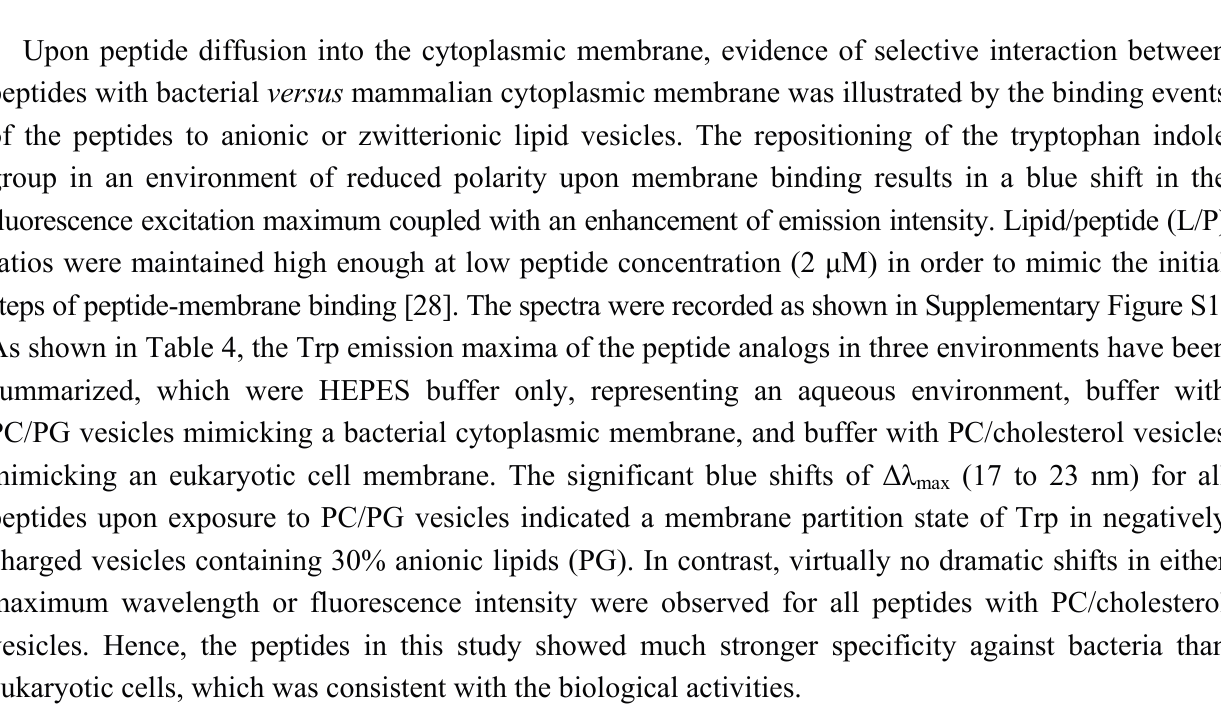
Table 4. Tryptophan fluorescence emission maxima of the peptides in HEPES buffer or in the presence of PC/PG (7:3, w/w) or PC/cholesterol (8:1, w/w) vesicles.